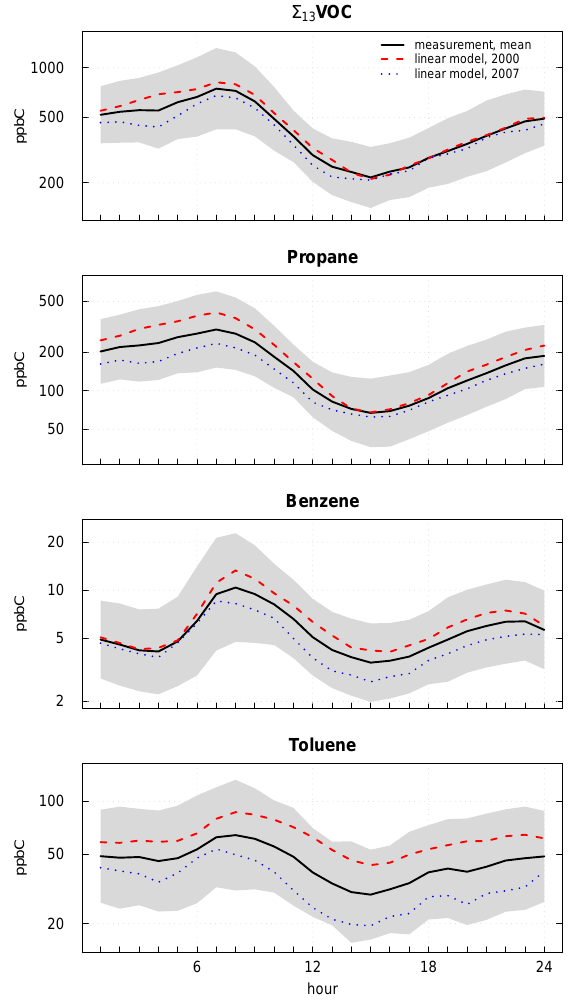
Fig. 3. Diurnal variation of 6 13 VOC, propane, benzene, and toluene. Shown are mean concentrations with standard deviations (solid line with grey shadow), as well as the modelled values for July 2000 and June 2007 (dotted lines).